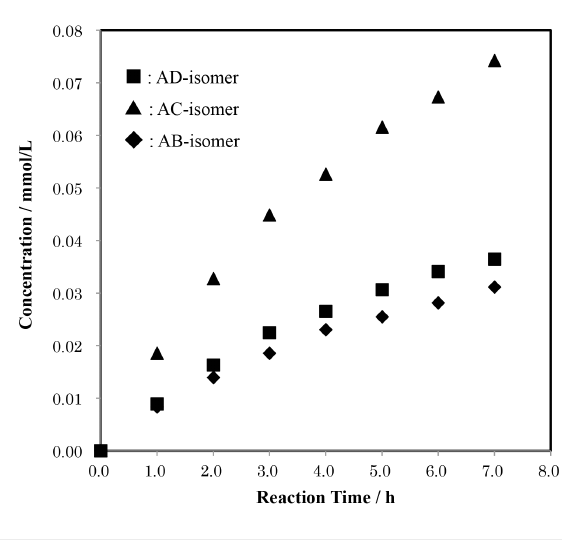
Figure 7: Time-course of the formation of the regioisomers of tri-6- O - trityl- α -CD in a reaction of AD-isomer with TrCl in pyridine at 55 °C. Average mole ratio of ABD : ABE = 1.00:0.25 ± 0.02.